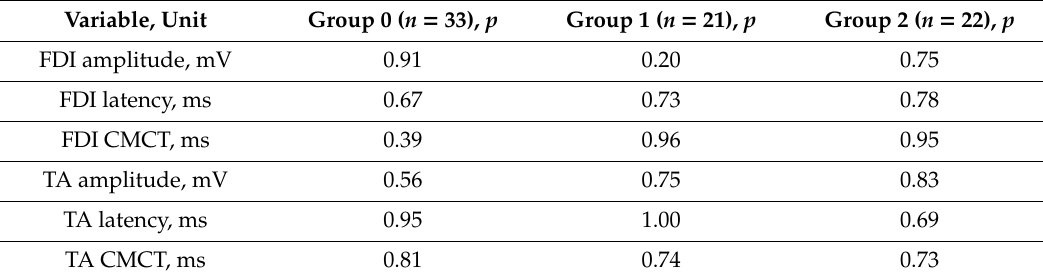
Table 2. Intragroup analysis of transcranial magnetic stimulation (TMS) variables (right vs. left) of the three groups (Mann–Whitney